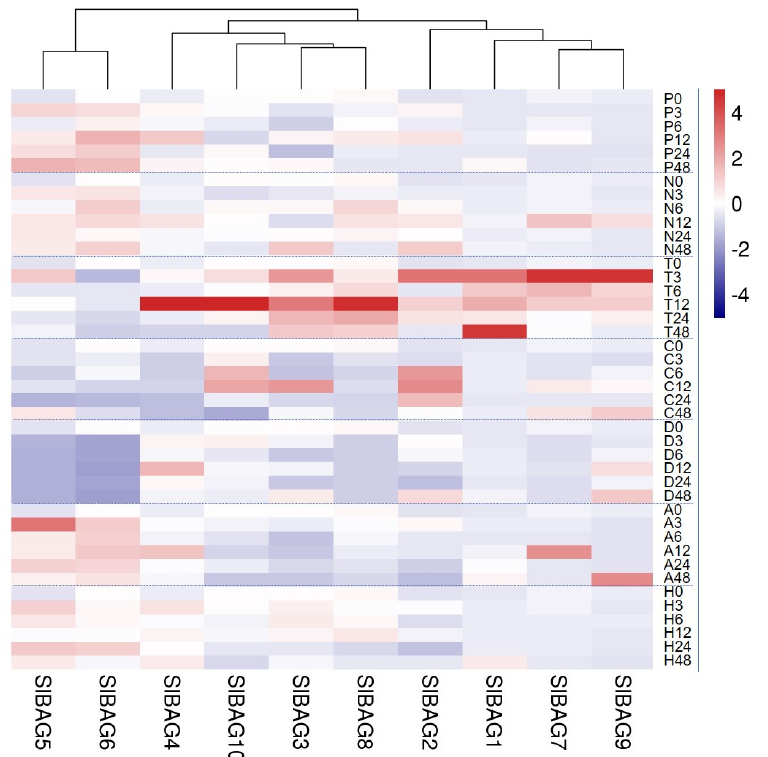
Figure 5. Expression profiles of SlBAG genes in tomato seedlings under different abiotic stresses. 20-day-old tomato plants were treated with PEG6000 (P, 20%), NaCl (N, 100 mM), high-temperature (T, 42 °C), cold (C, 4 °C), cadmium (D, 50 uM), ABA (A, 100 uM), or H 2 O 2 (H, 10 mM) for 0, 3, 6, 12, 24, and 48 h. Total RNA from tomato leaves at indicated time was extracted from different organs (root, stem, leaf, flower, green fruit, and red fruit) for qRT-PCR. Three independent biological repeats were performed ( n = 3). The bar in the upper right corner represents the expression value of log2, and the change of expression level is represented by the change in color. Red indicates relatively high expression and blue indicates relatively low expression.